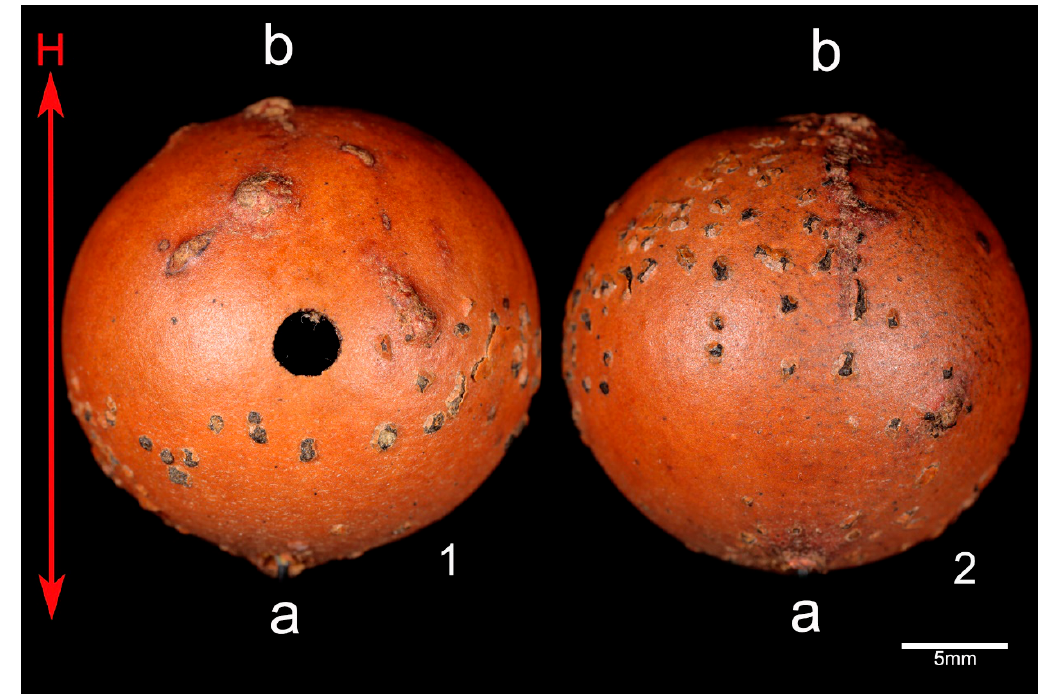
Figure 2. Galls used for the survey were divided into two halves (1, 2) according to the height line (H), keeping the hole produced by the emerging cynipid in the middle of one of the halves. The insertion point of the gall is also shown on the tree branch (a) and the opposite peak (b).